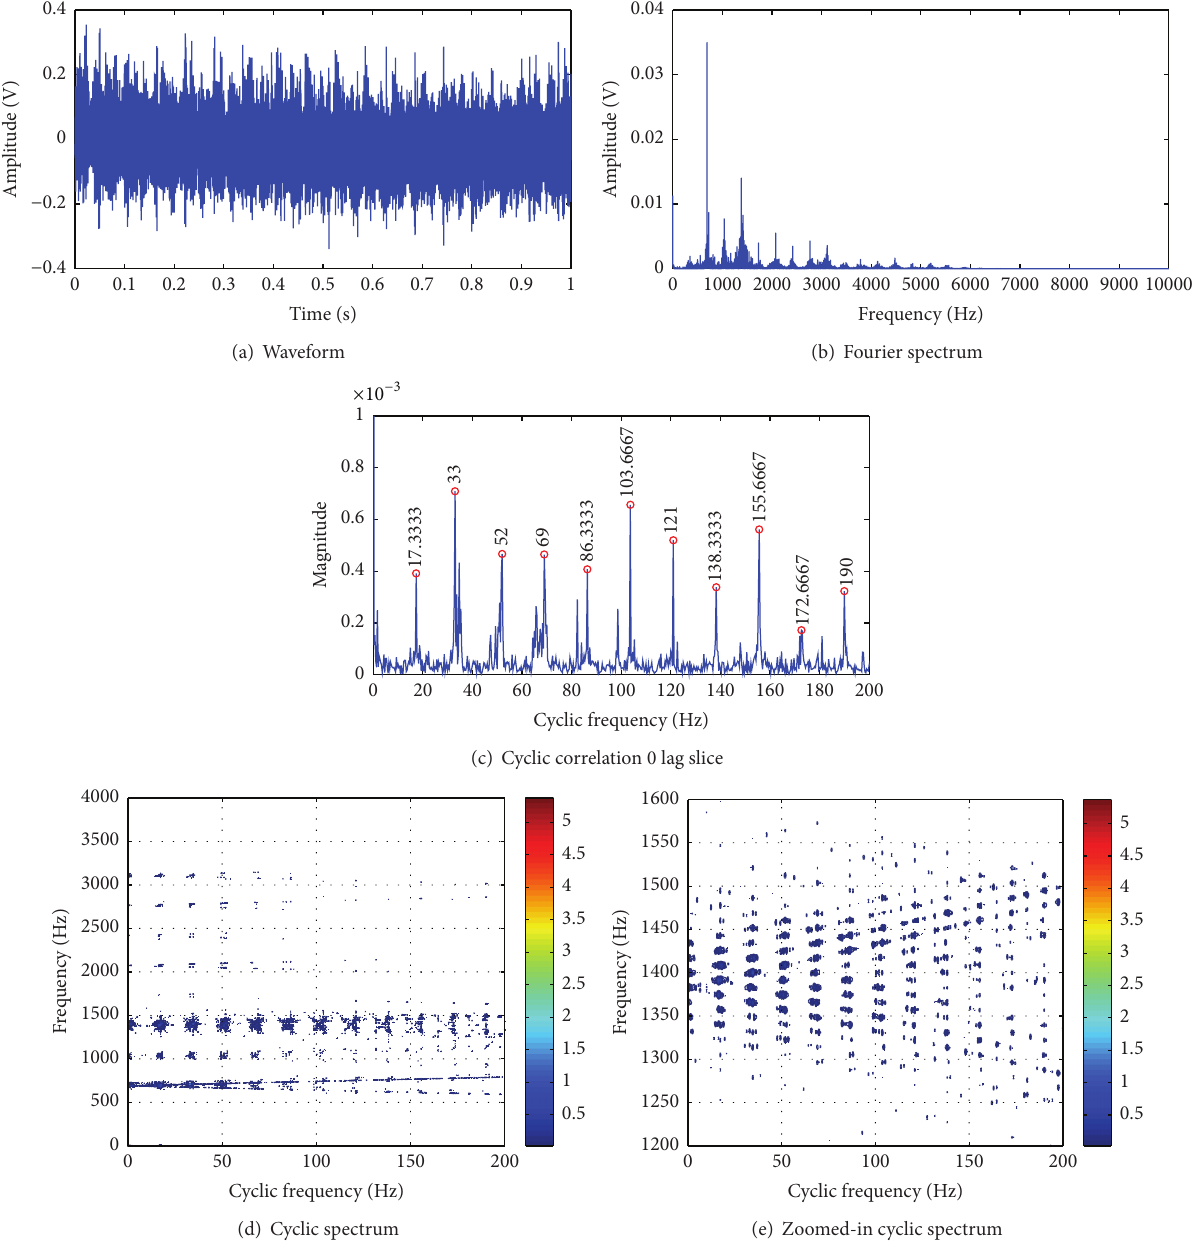
Figure 4: Faulty gearbox